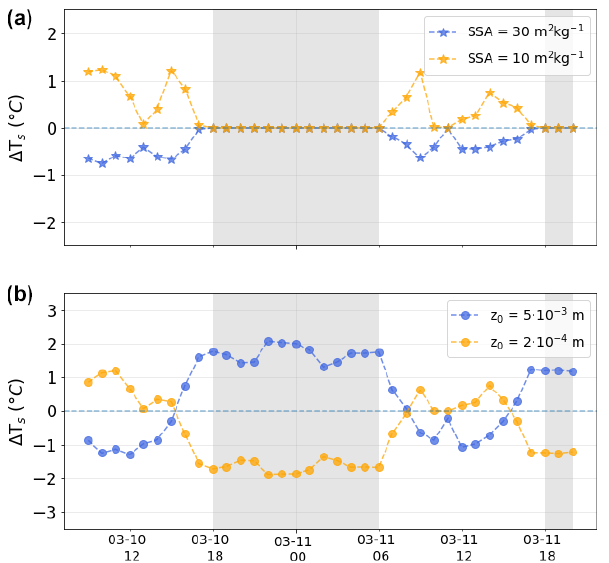
Figure 11. Changes in simulated snow surface temperature ( (cid:49)T s ) for a diurnal cycle at the FluxAlp station when varying the specific surface area (SSA; a ) and the aerodynamic roughness length ( z 0 ; b ). The shaded areas correspond to nighttime (i.e. SZA below 0 ◦ or over 90 ◦ ).